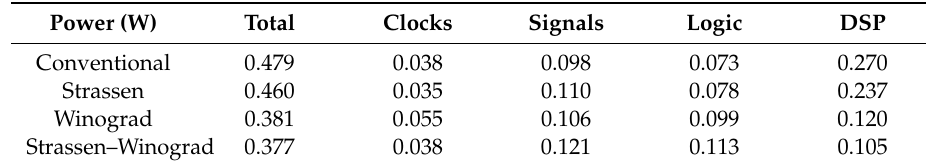
Table 3. Power consumption for different designs.